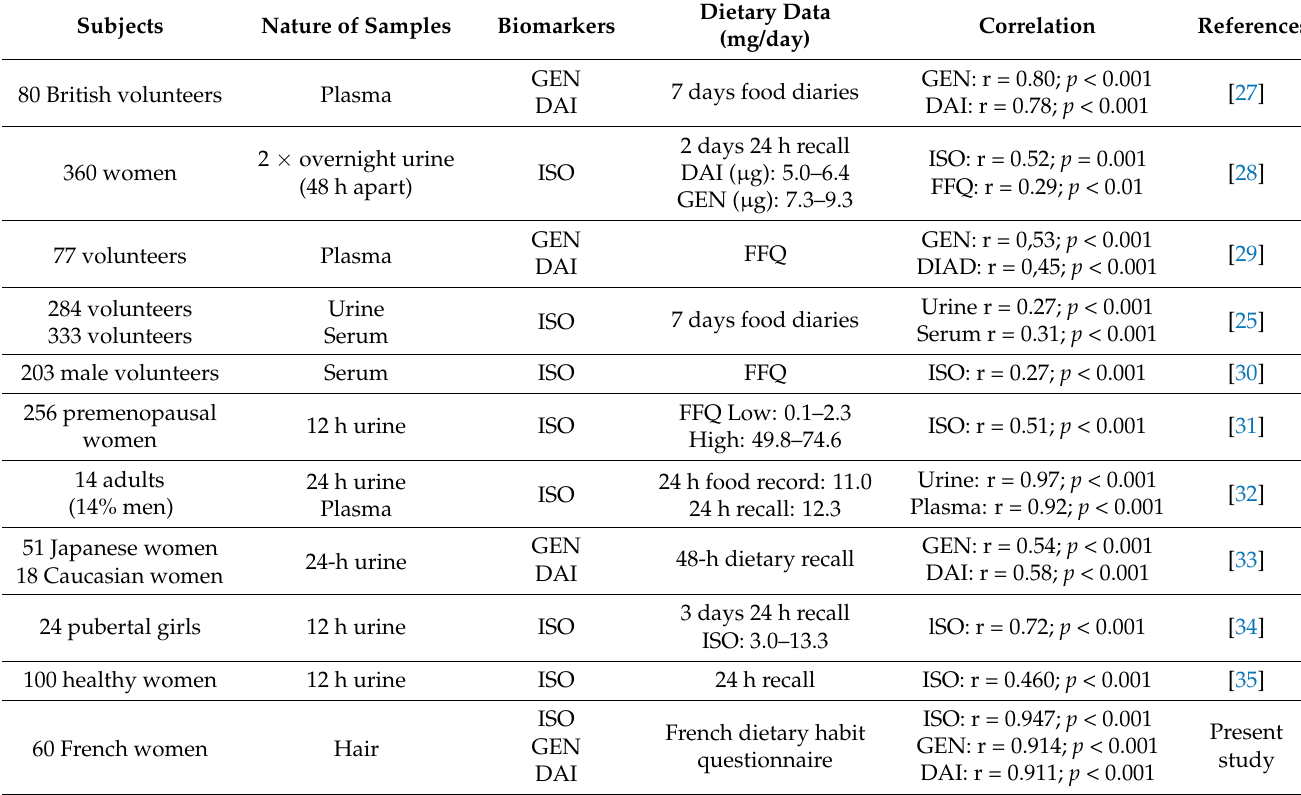
Table 4. Overview of different studies on blood or urine isoflavones as biomarkers of dietary exposures and present